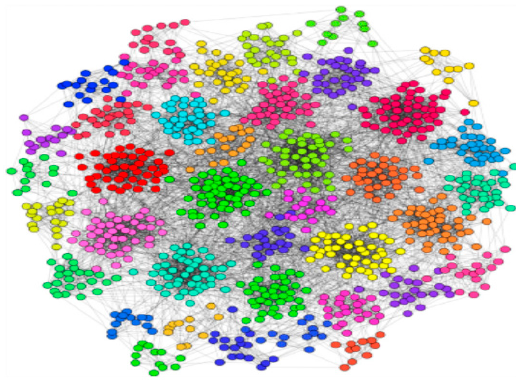
Figure 25. Visualization of the clusters found by the clustering algorithm (Ref. [110]).